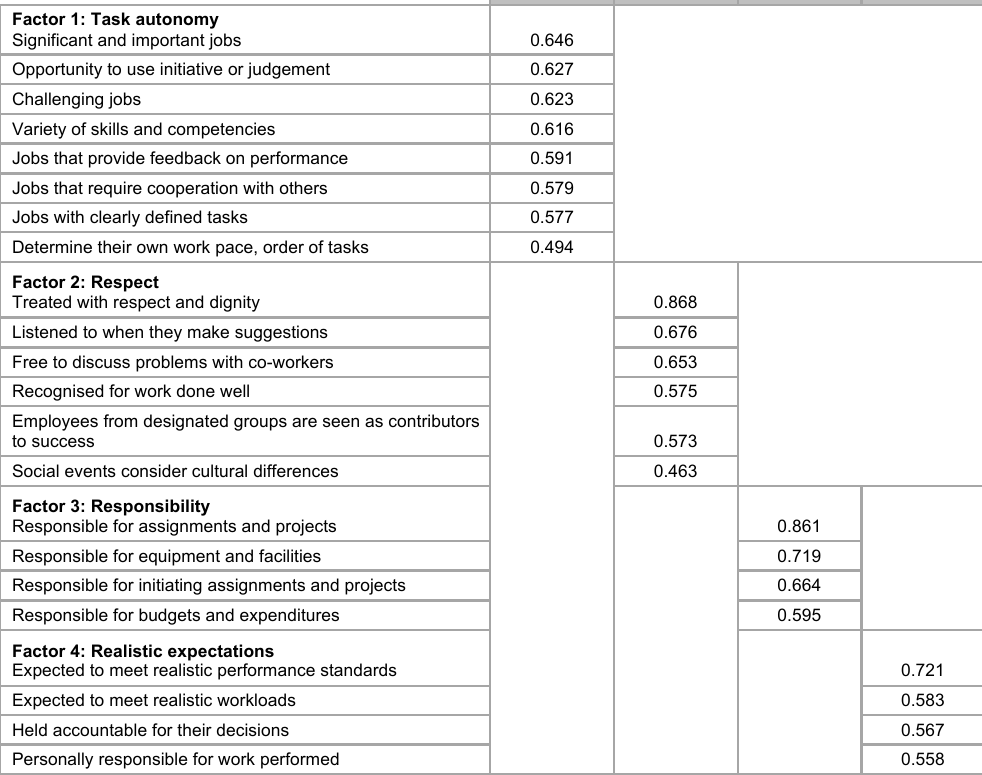
groups. Four factors in respect of employee treatment were identified.